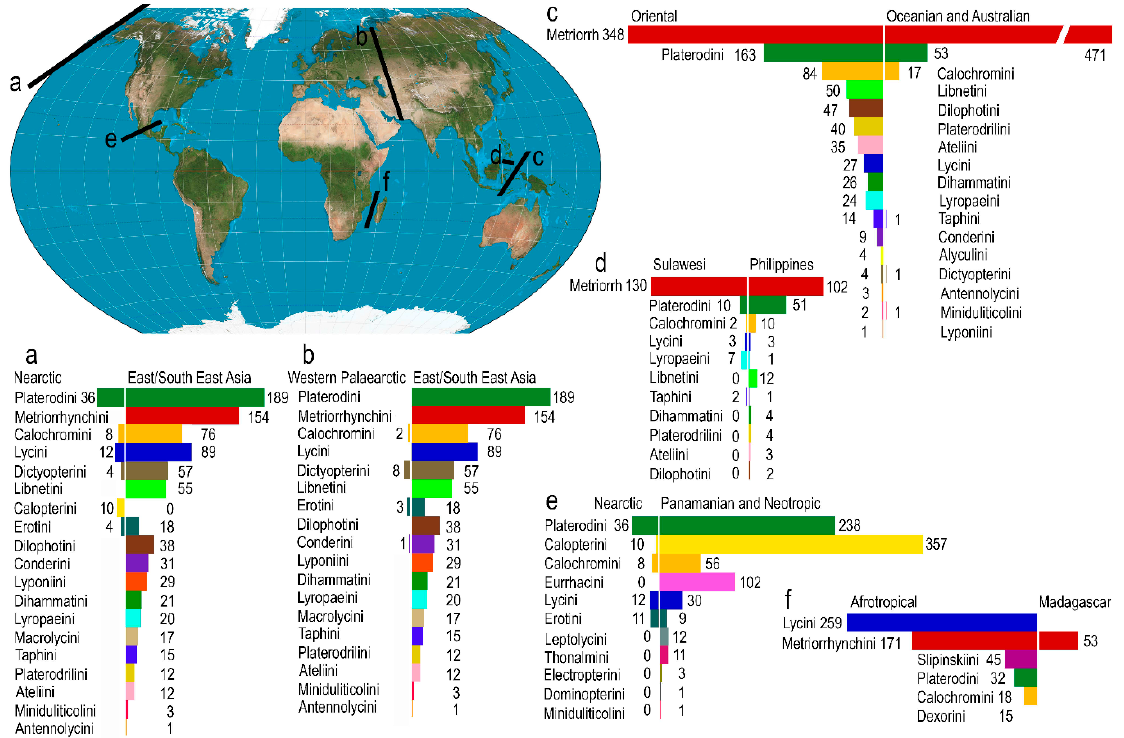
Figure 4. Position of zoogeographic boundaries with the high tribe-level turn-over.